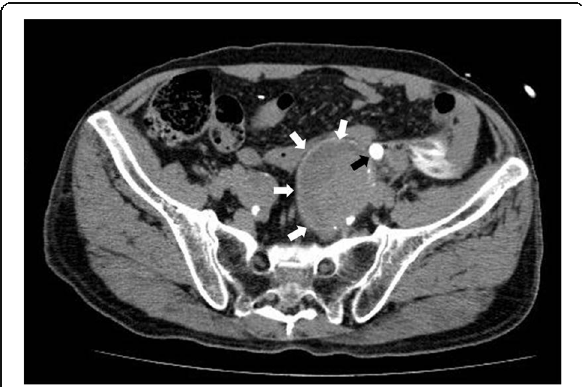
Fig. 1 Contrast-enhanced computed tomography (CT) reveals a large left internal iliac aneurysm (white arrows). CT signs of a ruptured aneurysm are not observed. A black arrow indicates the left hydroureter